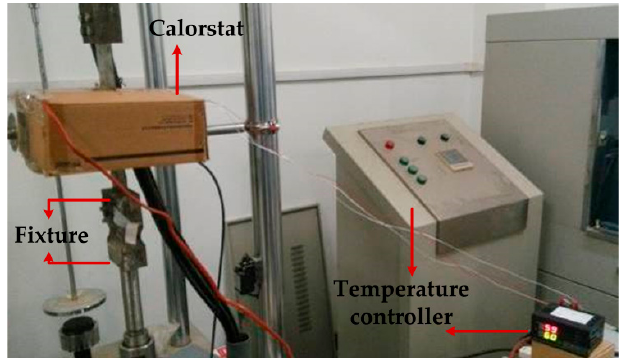
Figure 11. The stress testing experiment in the constant control of the temperature controller.